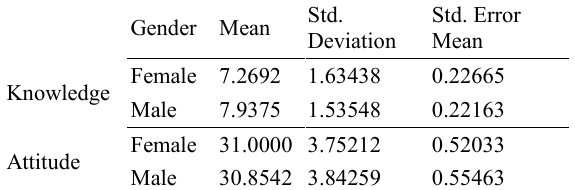
Table 6. Mean SD of knowledge and attitude scores among men and women Std. Std. Error Gender Mean Deviation Mean Female 7.2692 1.63438 0.22665 Knowledge Male 7.9375 1.53548 0.22163 Female 31.0000 3.75212 0.52033 Attitude Male 30.8542 3.84259